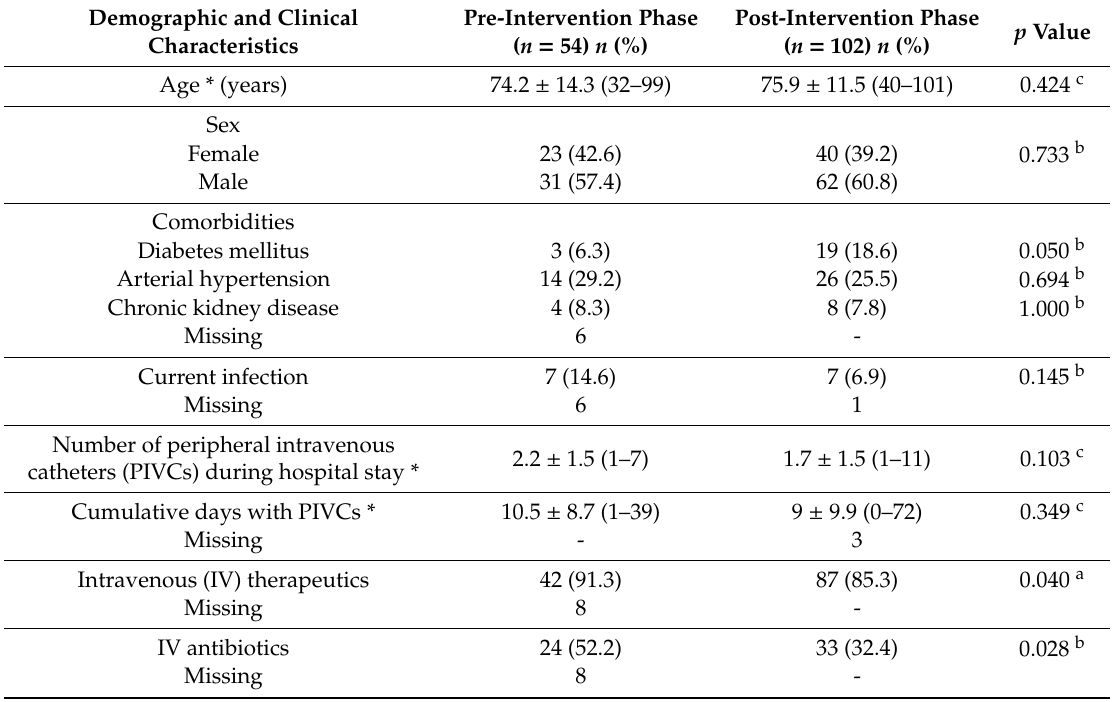
Table 1. Demographic and clinical characteristics of study patients in each phase and the statistical significance between the study groups ( n =